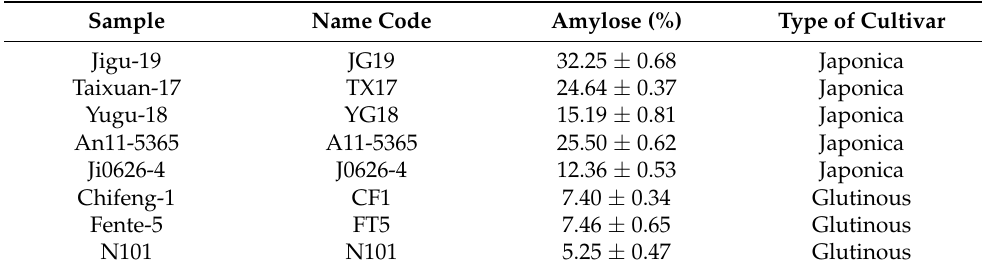
Table 1. Foxtail millet